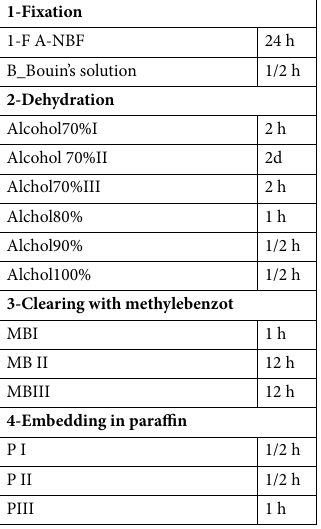
Table1. The processing time of the samples in paraffin embedding techniques. NBF (neutral buffer formalin), h hours, d days, MB I methyl bonzoate1, MB II methyl benzoate II, PI paraffin I, P II paraffin II, P III paraffin